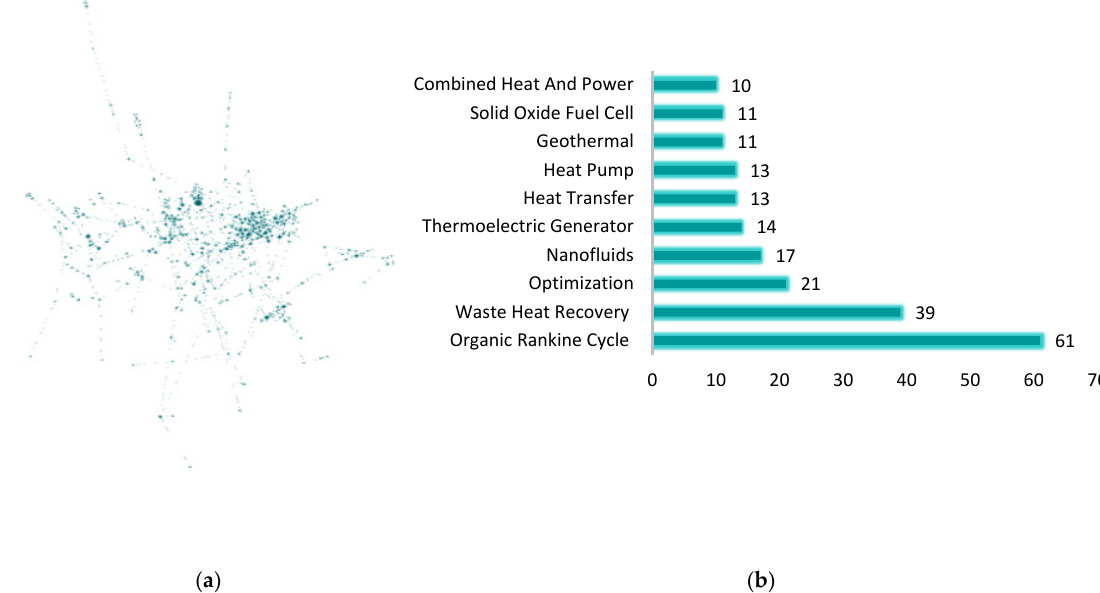
Figure 21 . Conversion of thermal/electrical energy: ( a ) manuscripts published, ( b ) keywords. Figure 21. Conversion of thermal / electrical energy: ( a ) manuscripts published, ( b )